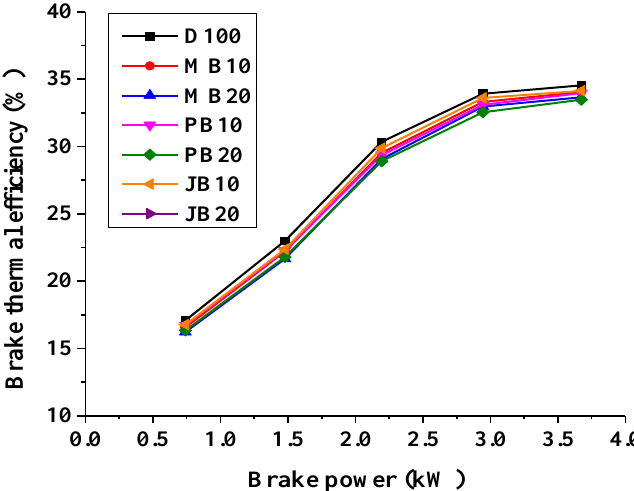
Figure 2. Comparison of brake thermal efficiency with respect to engine loading for microalgae, polanga, and jatropha biodiesel blends.